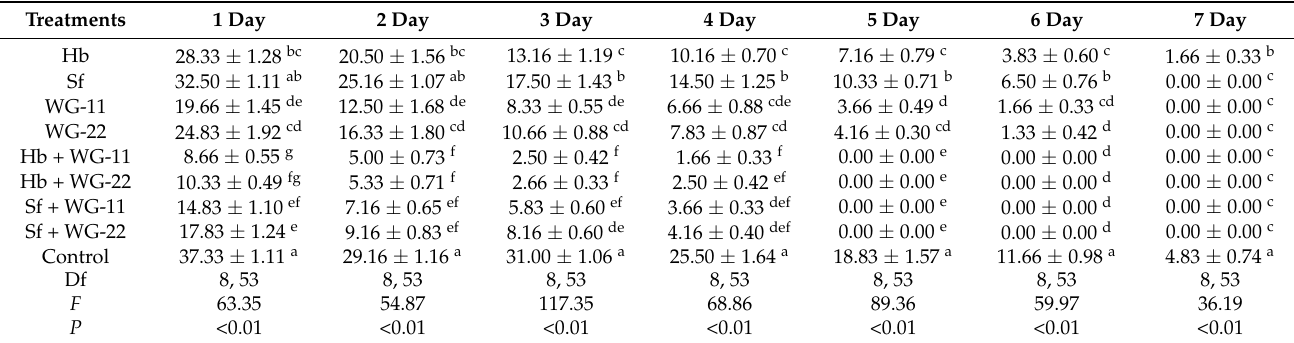
Table 3. Mean ( ± SE) adult emergence of Thrips tabaci at 1, 2, 3, 4, 5, 6, and 7 days when treated with Hb = Heterorhabditis bacteriophora , Sf = Steinernema feltiae , WG-11 = Beauveria bassiana , WG-02 = Metarhizium anisopliae (WG-02), Hb + WG-11 = H. bacteriophora + B. bassiana , Hb + WG-02 = H. bacteriophora + M. anisopliae , Sf + WG-11 = S. feltiae + B. bassiana , Sf + WG-02 = S. feltiae + M. anisopliae, control = water only in a potted plant bioassay under greenhouse conditions. Different letters in each column indicate statistical significance ( p < 0.05; Tukey’s test).